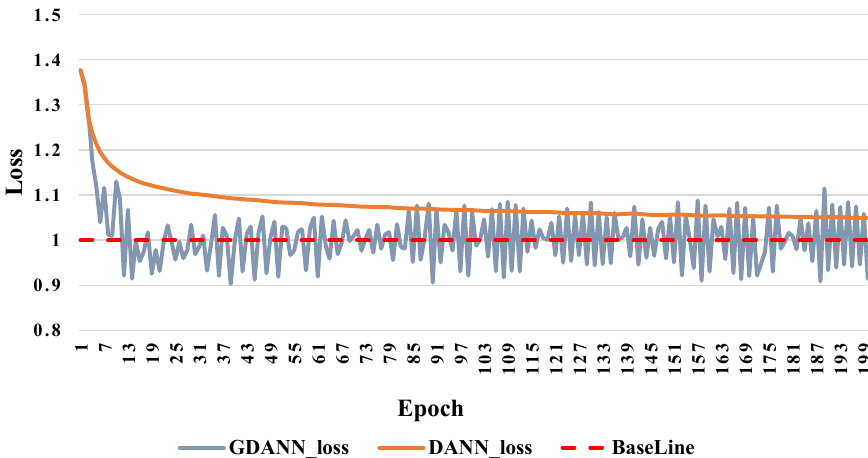
Figure 10. Loss of DANN and GDANN on EEG DataSet Others_Subject#1. (The Baseline refers to the saddle point where the training converged and reached the global optimal value, i.e.,